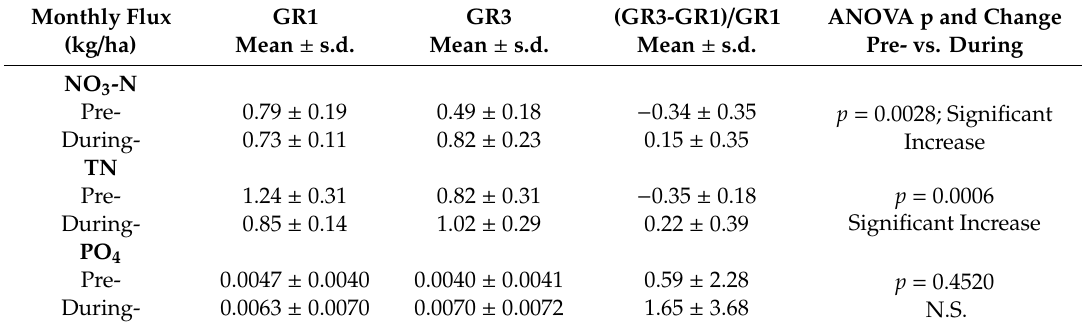
Table 2. Monthly nutrient flux means with one standard deviation. ANOVA p -values are listed for normalized net flux at GR3 comparisons ((GR3 flux-GR1 flux) / GR1 flux). p < 0.05 is significant, and N.S. is not